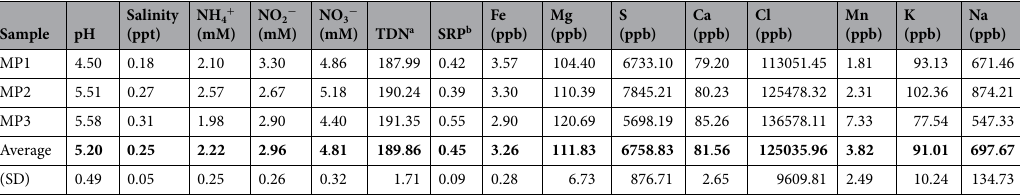
Table 1. Chemical analysis of ice meltwater from Mount Pond Glacier. a TDN: Total dissolved nitrogen. b SRP: Soluble reactive